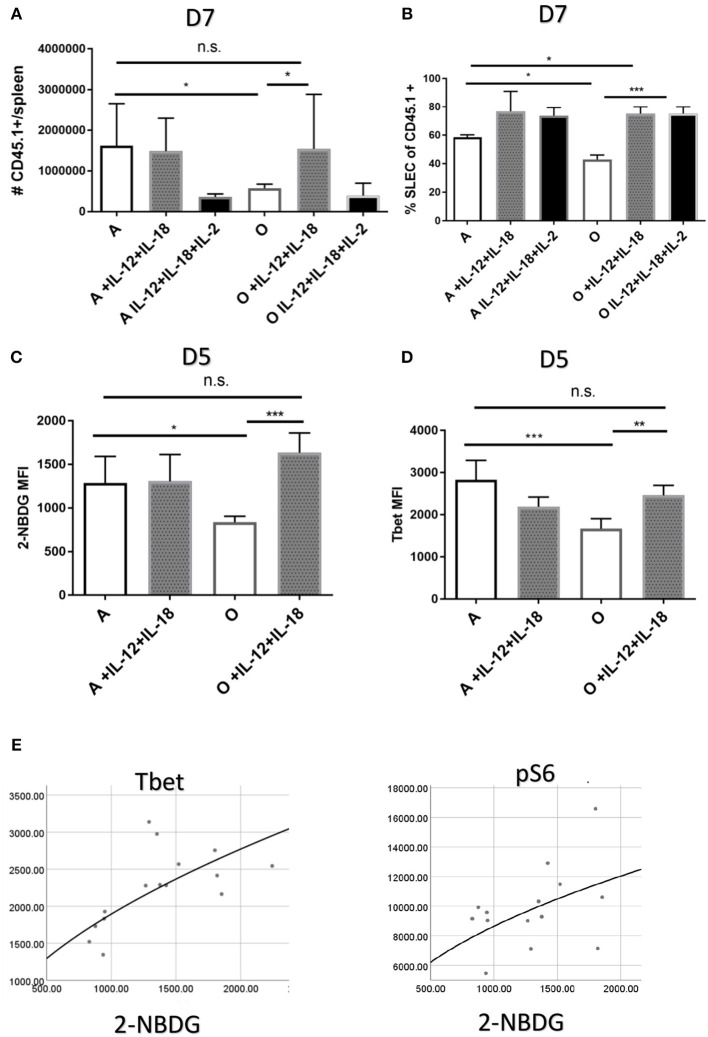
Treatment with recombinant IL-12 and IL-18 repairs the priming defect in the old organism. Adult and old C57/B6 (CD45.2+) mice (N = 10) received 5,000 adult naïve OT-1 CD8 T cells (CD45.1+). Next day mice were inoculated intravenously (i.v.) with 104 CFU Lm-OVA and were consequently treated on days 4–6 p.i. with 0.5 μg of rIL-12 and rIL-18 with or without IL-2 cytokine antibody complexes. (A) IL-12 and IL-18 treatment increased the antigen specific response on day 7 in old mice but not in the adult while addition of IL-2 complex was inhibitory (B). SLEC differentiation was significantly upregulated by cytokine treatment in both adult and old mice. (C) Glucose uptake early in infection (day 5) was upregulated by IL-12 and IL-18 only in old animals as well as (D) T-bet expression. (E) Multiple regression analysis with 2-NBDG (glucose uptake) as the dependent variable showed association only with T-bet and pS6k expression (*p < 0.05, **p < 0.01, ***p < 0.001, ****p < 0.0001).